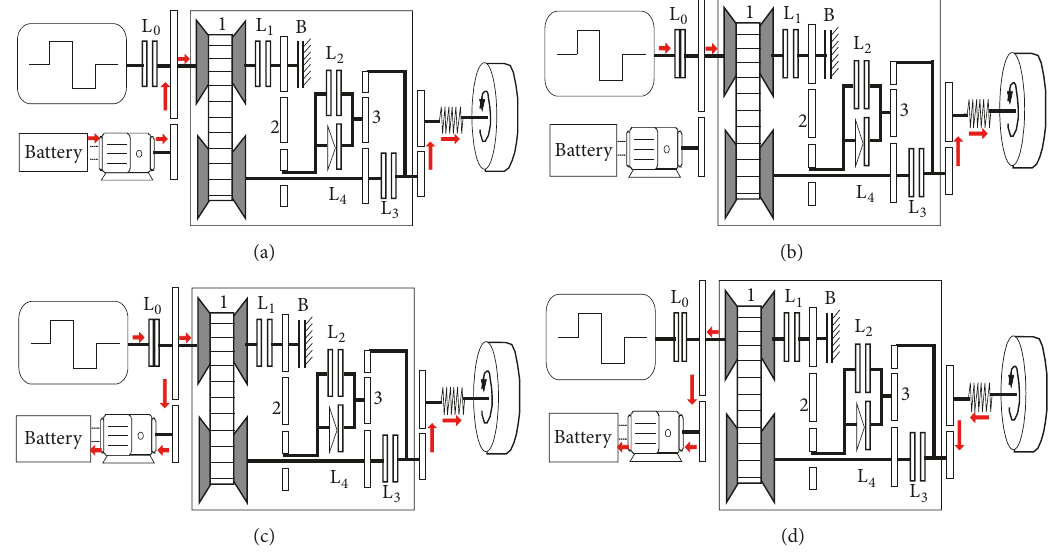
Figure 2: Working modes of super-mild HEV: (a) only-motor. (b) only-engine. (c) Engine-charging. (d) Regenerative